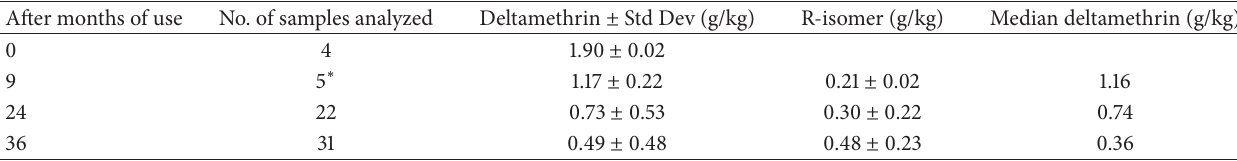
Table 4: Chemical analysis of bed nets collected after 2 and 3 years of use.